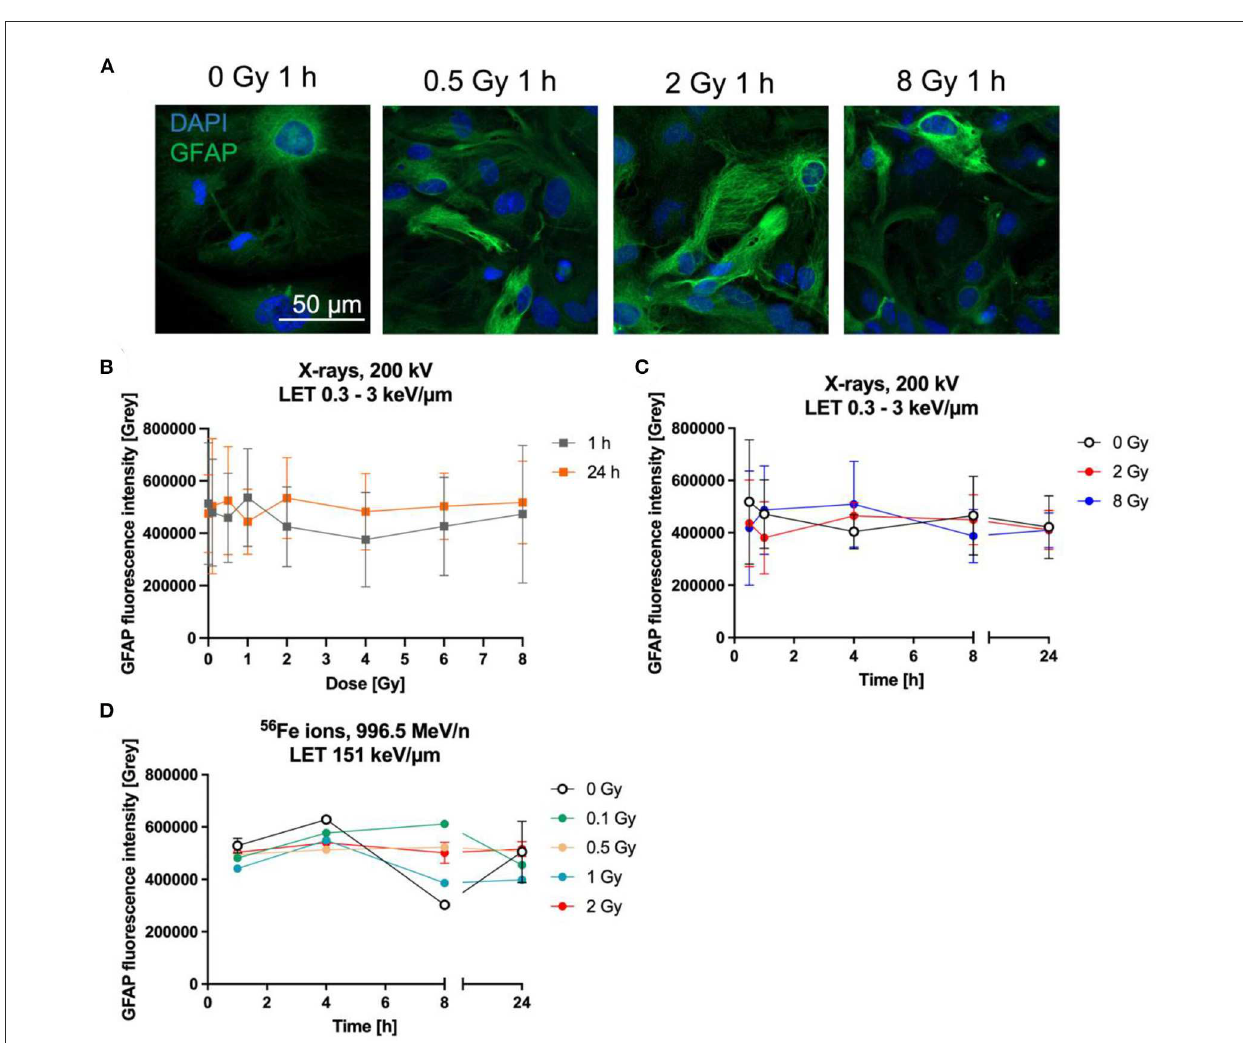
FIGURE7 Astrocytes did not become reactive after radiation exposure. Astrocytes were exposed to X-rays (200 kV, 15mA) with doses up to 8Gy (A–C) or to iron ions (D) and fixed for GFAP immunostaining after different time points. (A) Exemplary microscopy images of GFAP (green) immunostaining showing an unirradiated control and cells irradiated with different doses of X-rays at 1h after radiation exposure. The nucleus was stained with DAPI (blue) for all images. Bar: 50 µ m. (B) Dose effect curves of astrocyte reactivity (GFAP) 1h and 24h after exposure to X-rays ( n = 5). (C) The GFAP fluorescence intensity of astrocytes irradiated with different doses of X-rays over a time course up to 24h reveals a basal expression of GFAP but no radiation-induced changes. The samples were compared via 2way ANOVA, based on a sample size n = 4 ( p < 0.05). (D) Exposure to different doses of 56 Fe ions (LET 151 keV/ µ m, 996.5 MeV/n) did not lead to a dose-dependent increase of GFAP expression, but astrocytes showed a basal expression ( n = 2). In (B–D) data are shown as mean ± SD. In case that the error bars are smaller than the symbol, they are not visible (D)